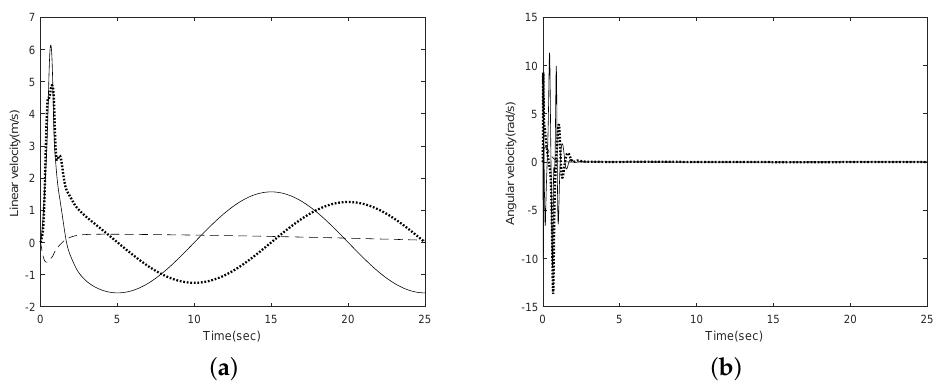
Figure 5. Velocities: ( a ) Linear velocities (solid: ˙ x , dotted: ˙ y , dashed: ˙ z ); ( b ) angular velocities (solid: ˙ φ , dotted: ˙ θ , dashed: ˙ ψ ).